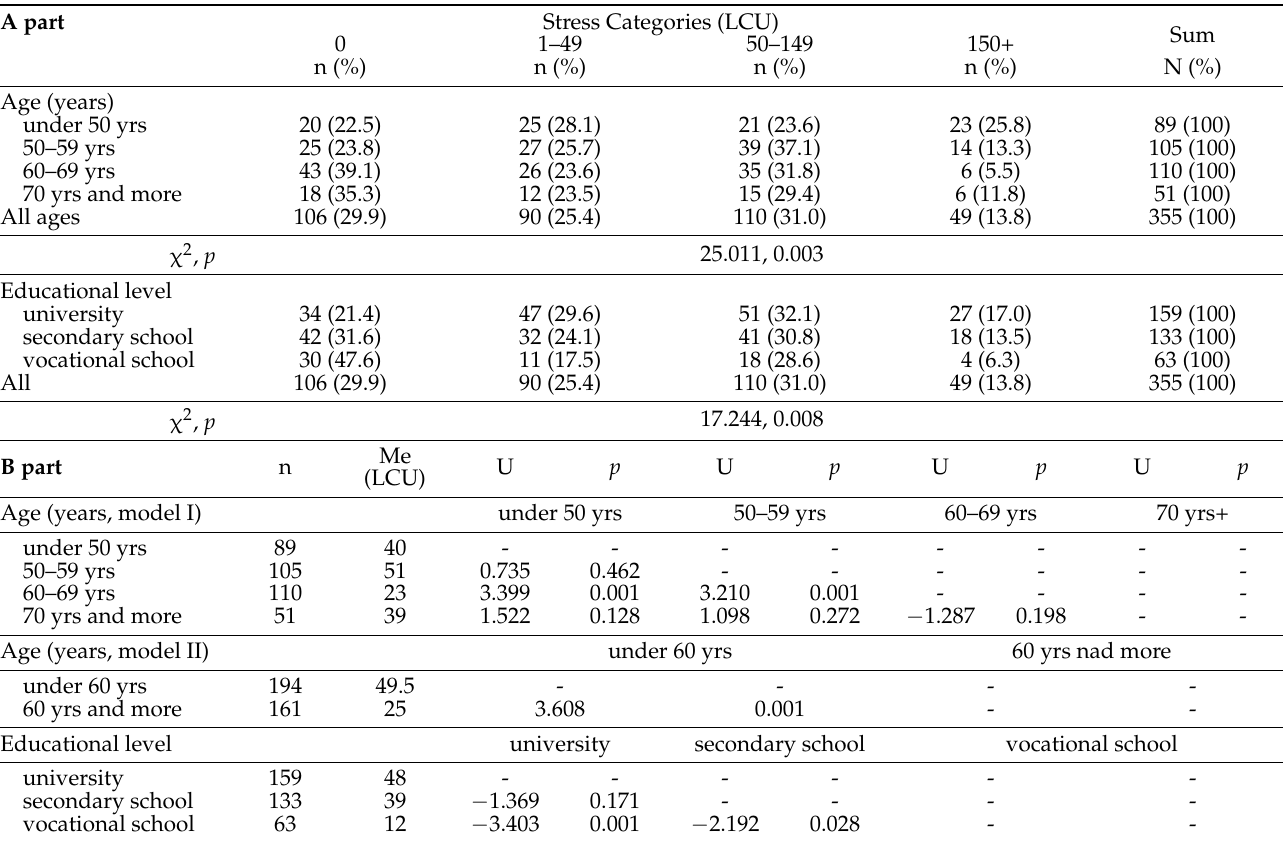
Table 1. Associations of stress with age and education: Part A—number of observations (n) and pro- portions (%) of stress categories by age and education groups and results of χ 2 and p ; Part B—results of the Mann–Whitney U test for stress by age and education